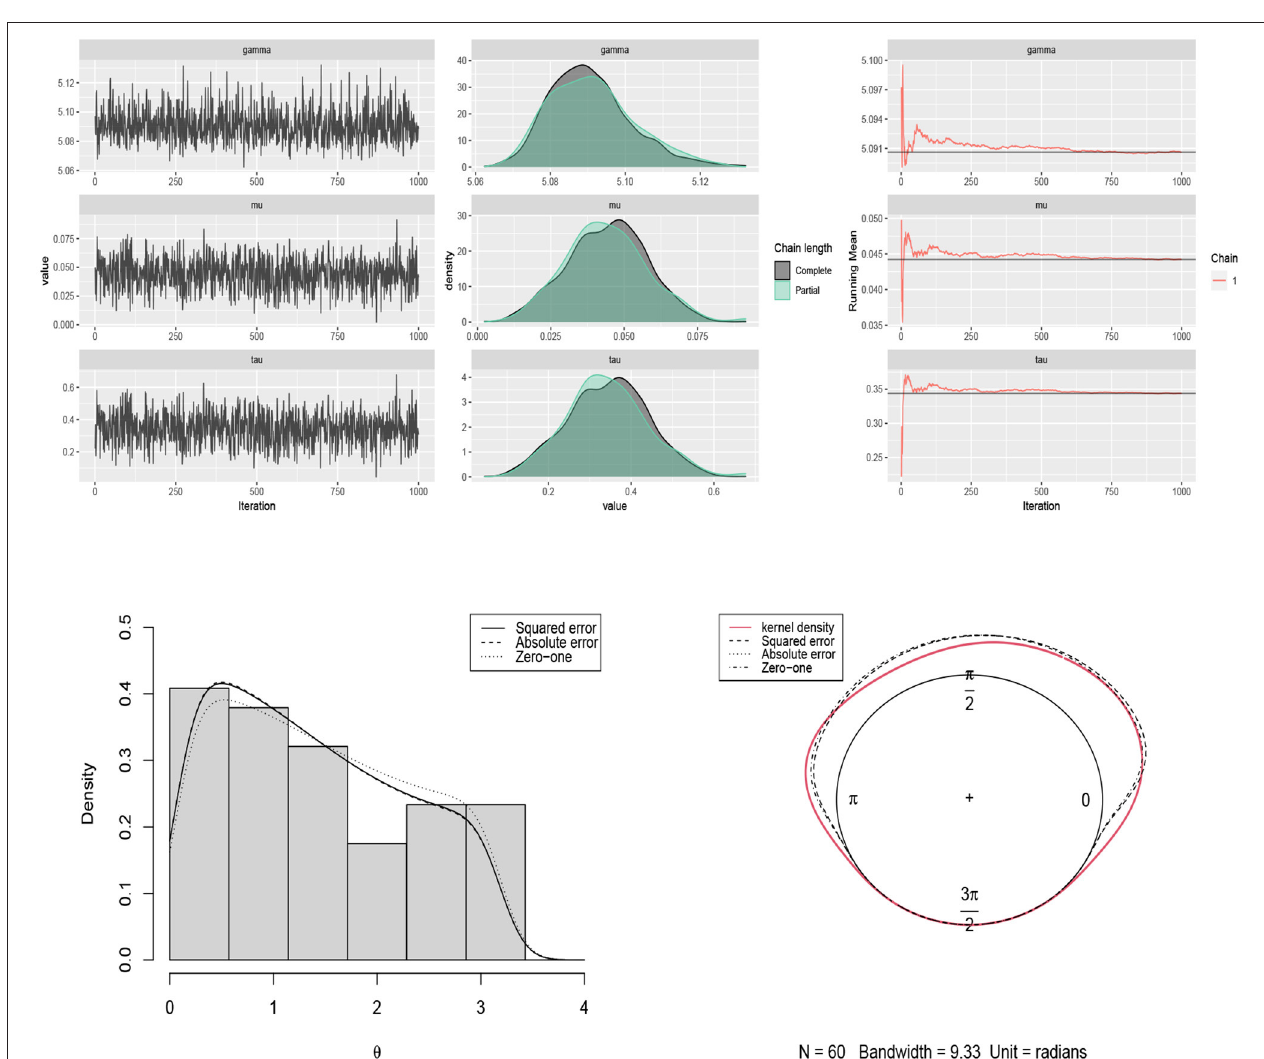
FIGURE 9 | (Top) traceplots, mean running and estimated posterior pdf plots of generated samples for ( µ , τ , γ ) in Table 3 for the long-axis orientations of feldspar laths dataset. (Bottom) the histogram and kernel density plot of the data related to the long-axis orientations of feldspar laths and the fitted curves under different loss